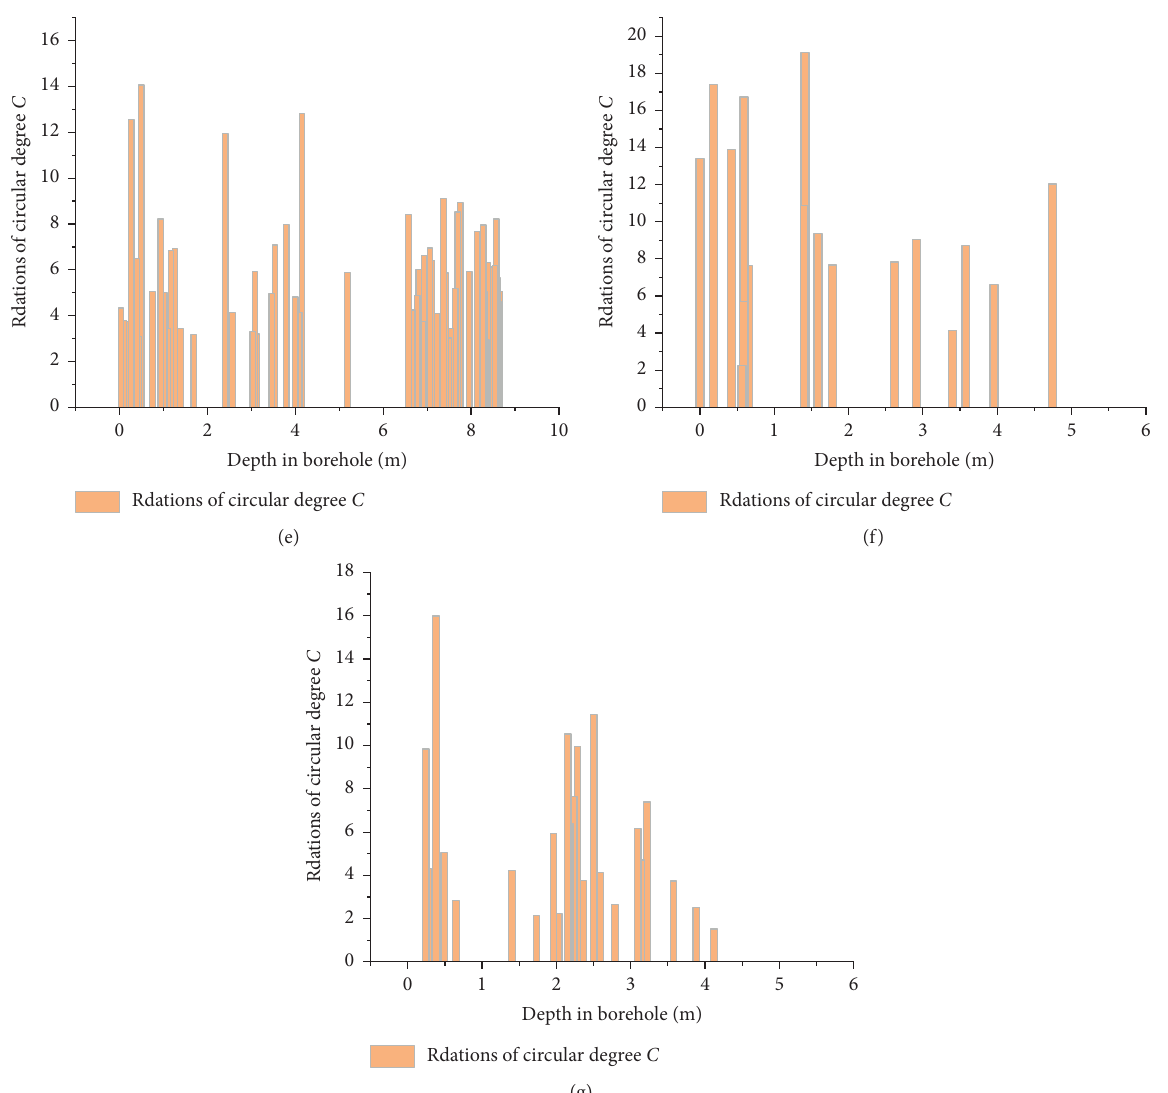
Figure 14: The distribution of C value at various borehole depths: (a) borehole #1 at station #2; (b) borehole #2 at station #2; (c) borehole #3 at station #2; (d) borehole #4 at station #2; (e) borehole #5 at station #2; (f) borehole #6 at station #2; (g) borehole #7 at station